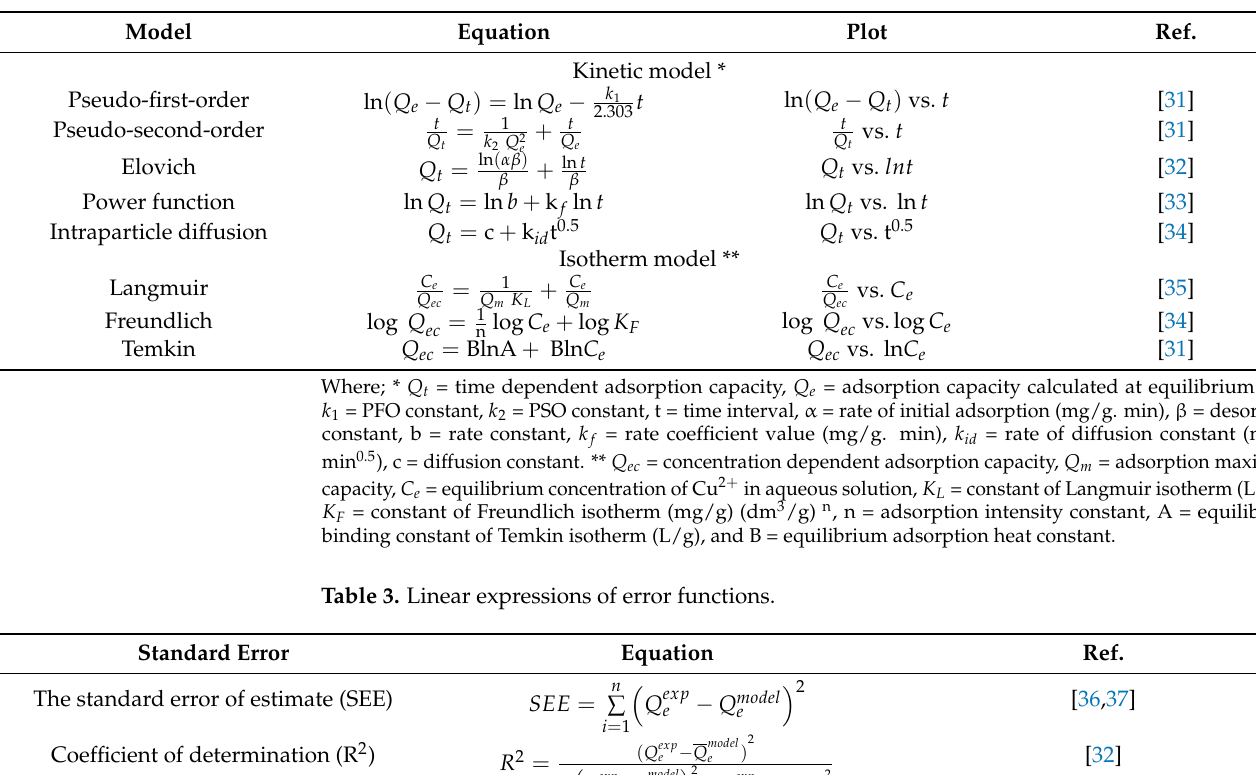
Table 2. List of kinetic and isothermal adsorption models.